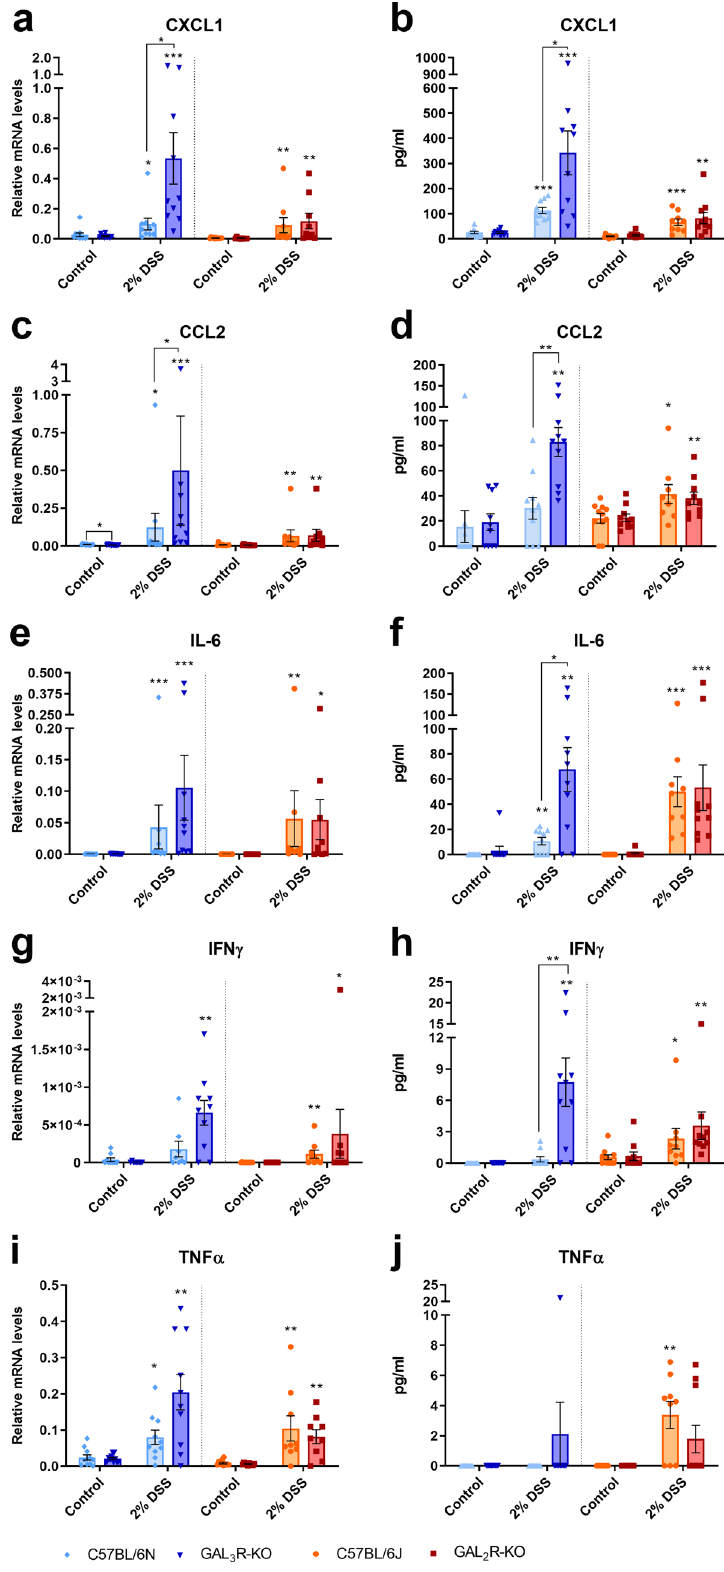
Figure 5. Relative mRNA expression levels ( a , c , e , g , i ) in the colon and plasma protein levels ( b , d , f , h , j ) of CXCL1 ( a , b ), CCL2 ( c , d ), IL-6 ( e , f ), IFNγ ( g , h ), and TNFα ( i , j ) in GAL 3 R-KO, GAL 2 R-KO and corresponding WT mice. Levels of mRNA were determined relative to the housekeeping gene HPRT. Data represent means ± SEM. n = 7–11. Data were analyzed by Kruskal–Wallis test followed by Mann–Whitney U test. * p < 0.05; ** p < 0.01; *** p < 0.001 versus corresponding controls or as